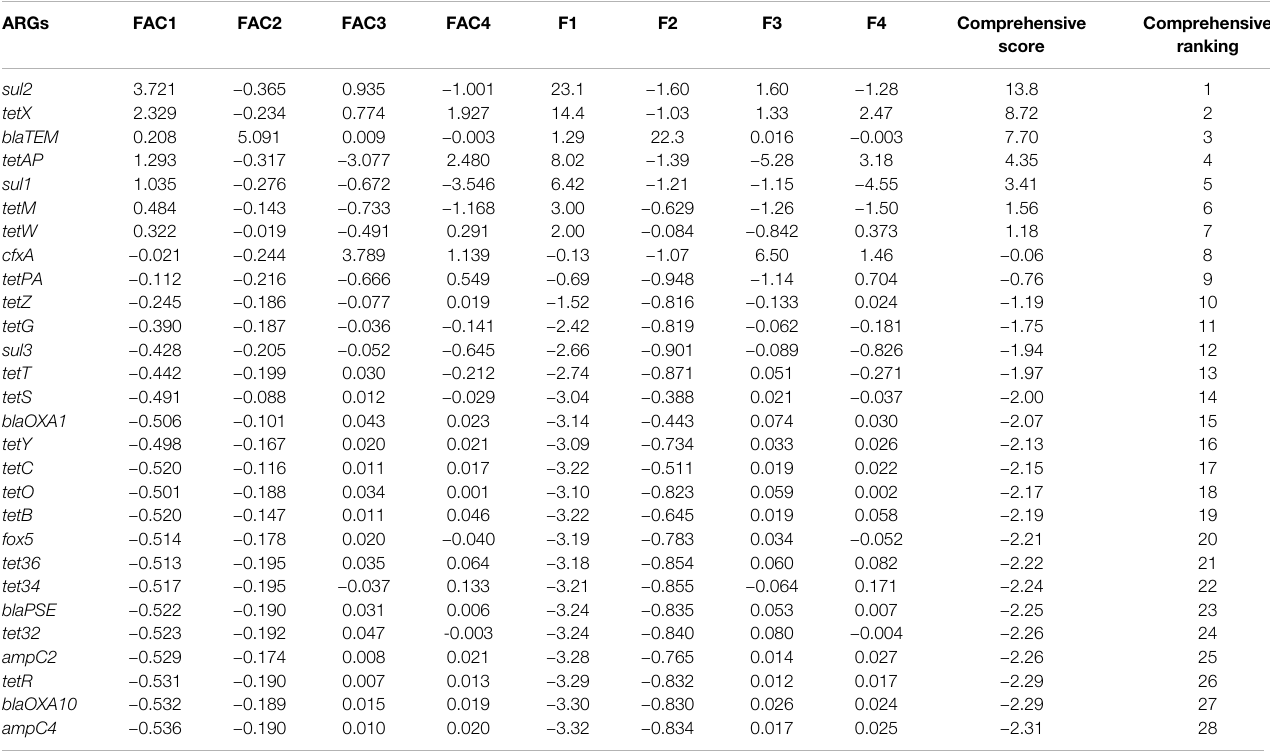
TABLE 3 | The comprehensive score of the PCA analysis for the ARGs.